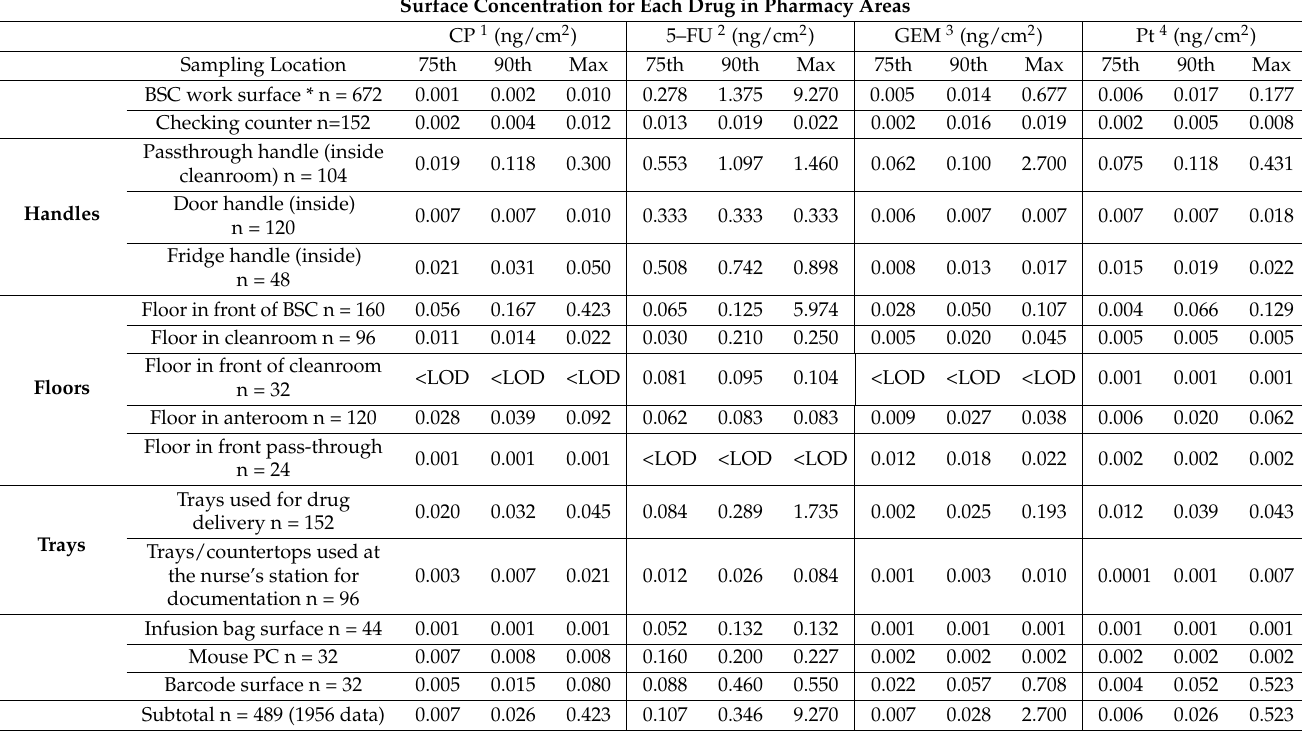
Table 4. Surface contamination reported as the 75th percentile, the 90th percentile, and the maximum value for each drug over the 5-year survey in wipe